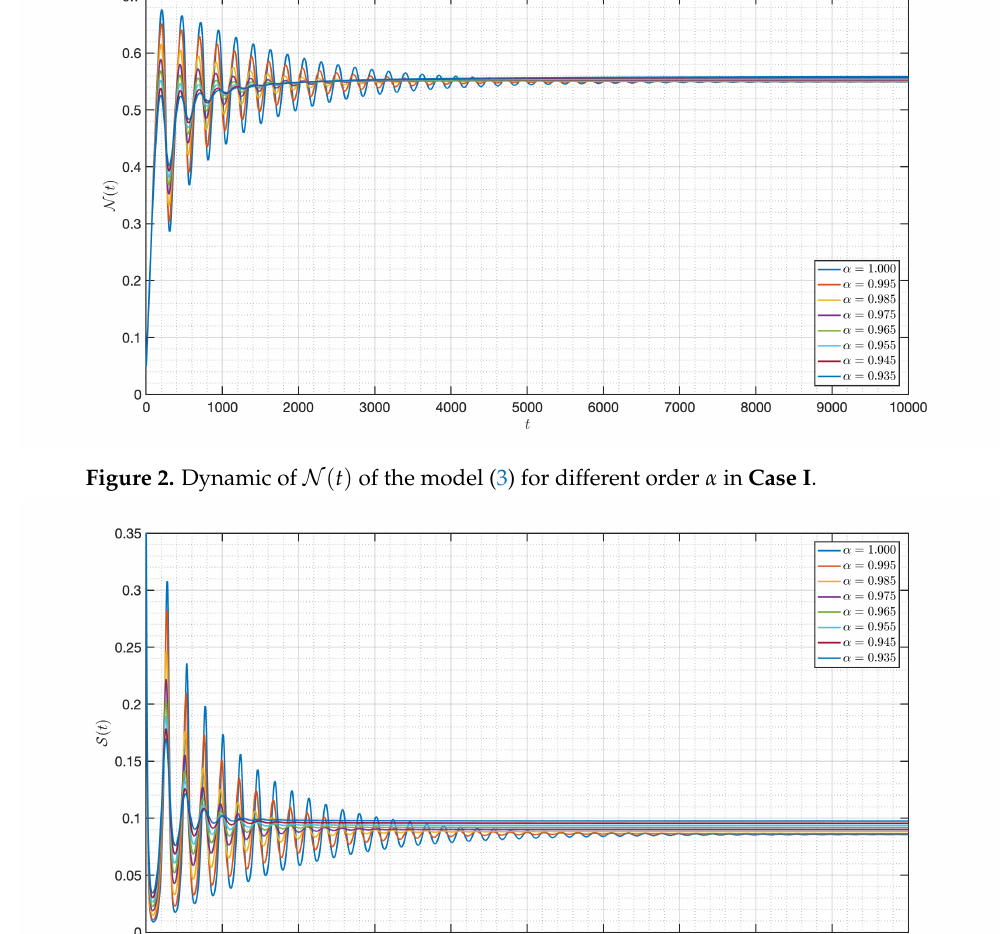
Figure 3. Dynamic of S ( t ) of the model (3) for different order α in Case I